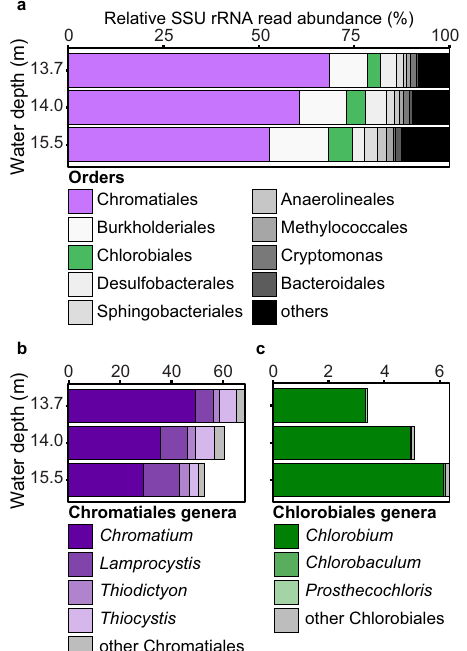
Fig. 3 In situ abundance and activity pro fi le of the microbial community in Lake Cadagno, based on relative small subunit rRNA read abundance in 2018. a Relative small subunit rRNA read abundance of the entire microbial community in Lake Cadagno chemocline classi fi ed to order level. Chromatiales (PSB) are indicated in purple, Chlorobiales (GSB) in green. b Relative small subunit rRNA read abundance of Chromatiales genera. c Relative small subunit rRNA read abundance of Chlorobiales